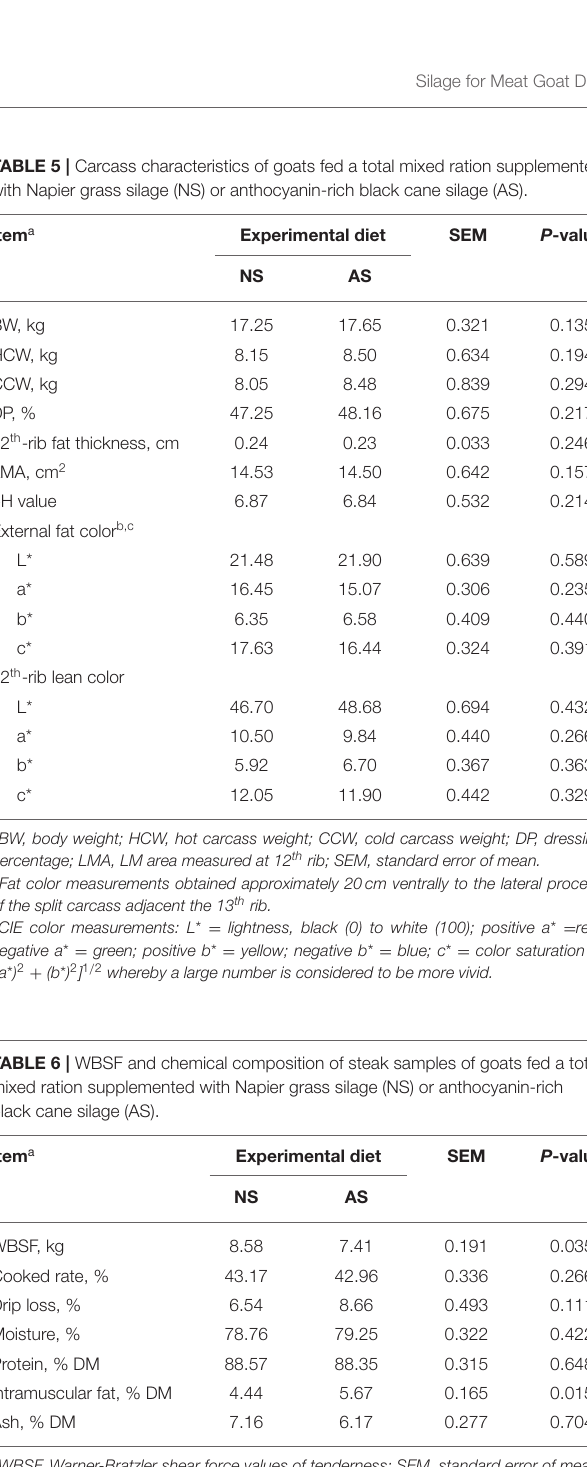
TABLE 4 | Blood biochemical indices of goats fed a total mixed ration supplemented with Napier grass silage (NS) or anthocyanin-rich black cane silage (AS).